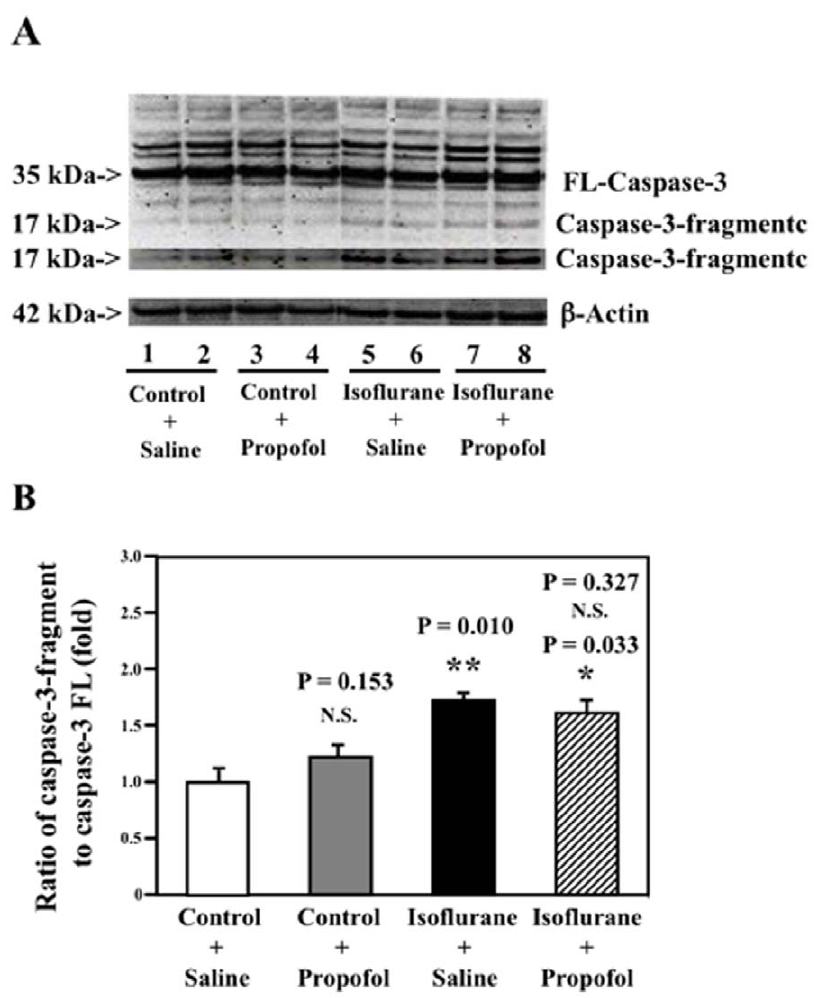
Figure 2. Propofol does not attenuate the isoflurane induced caspase-3 activation in H4 naive cells. A. Treatment with 2% isoflurane (lanes 5 and 6) induces caspase-3 activation as compared to the control condition (lanes 1 and 2). The treatment of propofol alone (lanes 3 and 4) does not induce caspase-3 activation as compared to the control condition (lanes 1 and 2). Propofol treatment (lanes 7 and 8) does not attenuate the 2% isoflurane-induced caspase-3 activation as compared to 2% isoflurane alone (lanes 5 and 6) in the H4 naive cells. There is no significant difference in amounts of b -Actin in the H4 naive cells following these treatments. B. Quantification of the Western blot shows that 2% isoflurane (black bar, ** P=0.010) induces caspase-3 activation as compared to control condition (white bar). The propofol treatment alone (gray bar) does not induce caspase-3 activation as compared to the control condition (white bar). Two-way ANOVA shows that the propofol treatment (net bar, P=0.327, N.S.) does not attenuate the isoflurane-induced caspase-3 activation in the H4 naı ¨ ve cells.